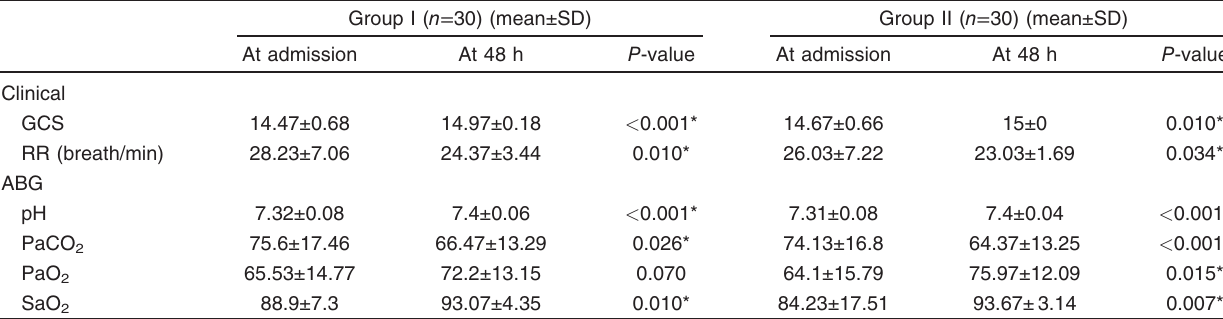
Table 5 Changes in Glasgow Coma Scale, respiratory rate, and arterial blood gases at 48 h